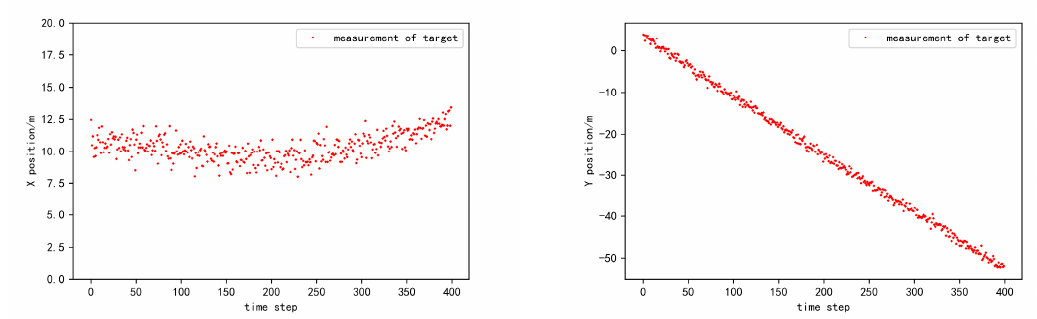
Figure 5. The position observation of the target in CV coordinate frame.